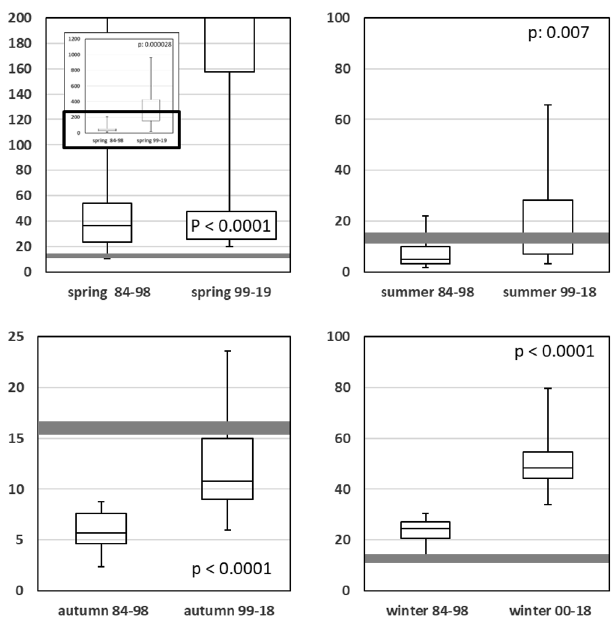
Figure 9. Seasonal comparison of DIN / SRP molar ratios for high and low eutrophication periods. The optimum value around 16 is highlighted as a gray bar. The black box in the spring plot has been magnified.